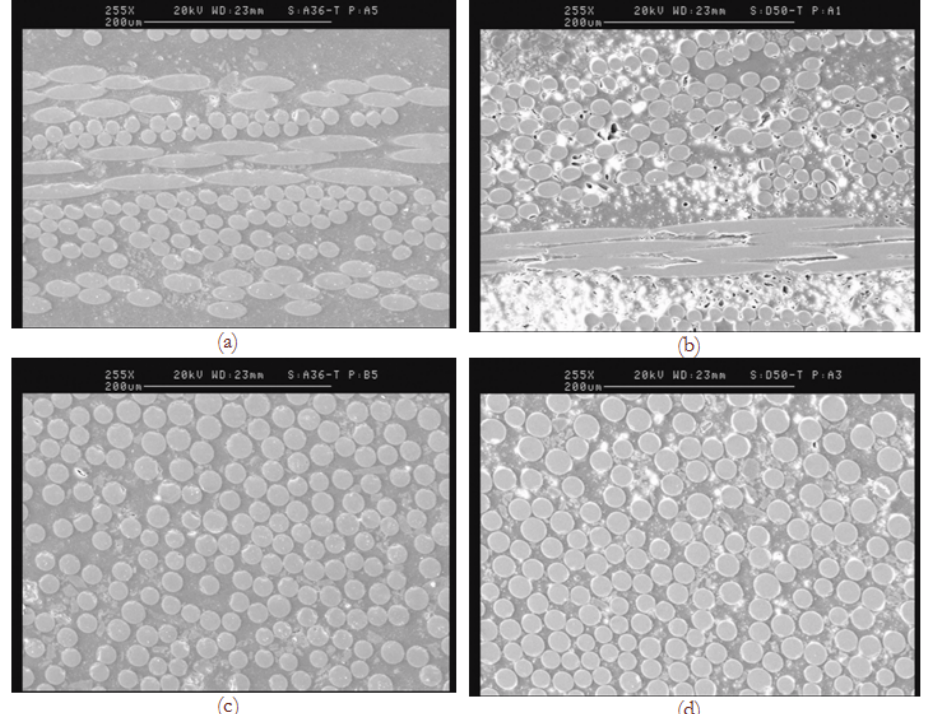
Figure 7: Damage evolution for increasing stress values (transversal section):